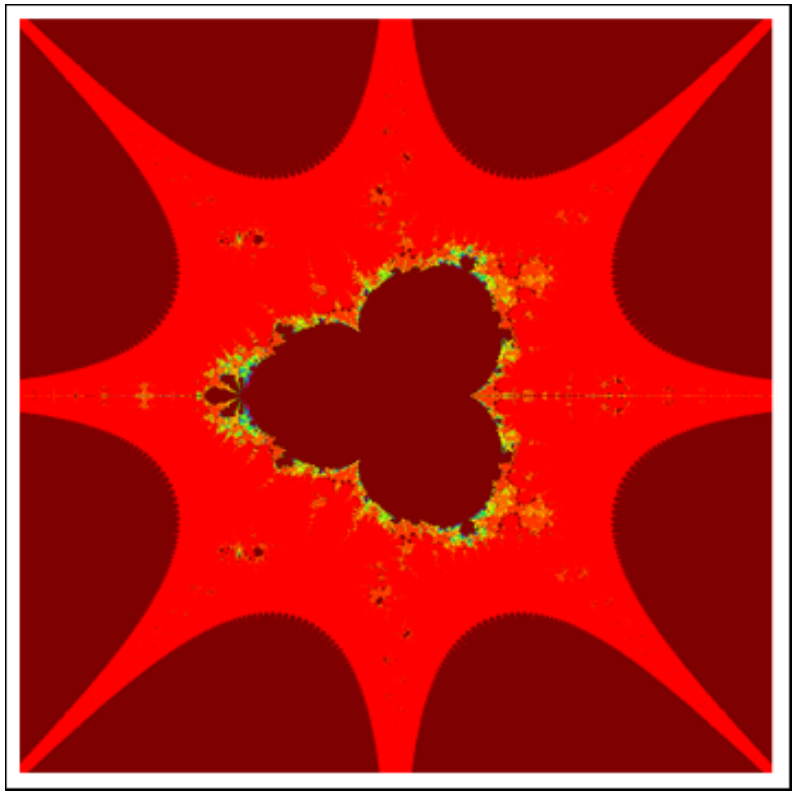
Figure 27. M-set for τ ( z ) = sin ( z 4 ) + c via DKIS. The image execution time is 502.296